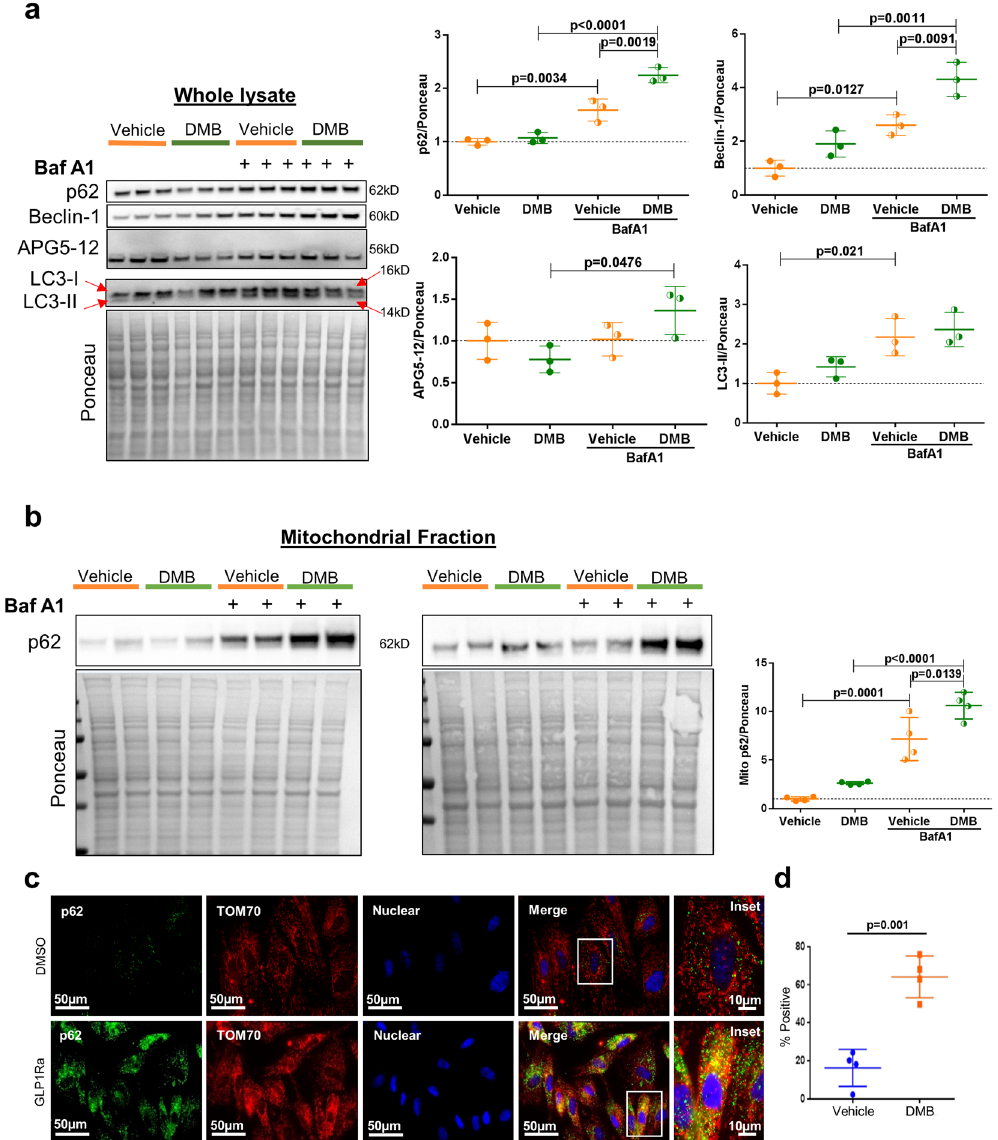
Figure 3. DMB induces mitophagy in H9C2 cells. Differentiated H9C2 cells were treated with vehicle (DMSO) or 1 µ M DMB overnight with or without autophagy inhibitor bafilomycin A1 (BafA1, 50 nM). (a) Western blot analysis and quantification of autophagy markers in the cell whole lysate (n = 3 plates/group); (b) Western blot analysis and quantification of p62 in the mitochondria-enriched subcellular fraction of DMSO or DMB-treated cells with or without BafA1 (n = 4 plates/group). The samples derive from the same experiment. The blots were processed in parallel and developed using the same exposure time. (c) Immunofluorescence microscopy of the mitophagy adapter p62/SQSTM1 and the mitochondrial protein TOM70 in DMSO and DMB-treated H9C2 cells, scale bars as indicated; (d) Percentage of cells showing colocalization of p62 and TOM70. (n = 4 plates/ group with 10 fields of cells captured for each plate. Scoring was performed blinded. All values are presented as mean ± standard deviation. ANOVA with Tukey posthoc test was used to compare the groups in A and B. Standard Student’s t -test was used to compare the groups in D. WB figures were cropped and all densitometry was performed using NIH ImageJ software v 1.51 (https://imagej.nih.gov/ij/download.html). Full-length blots/ gels are presented in Supplementary Figure